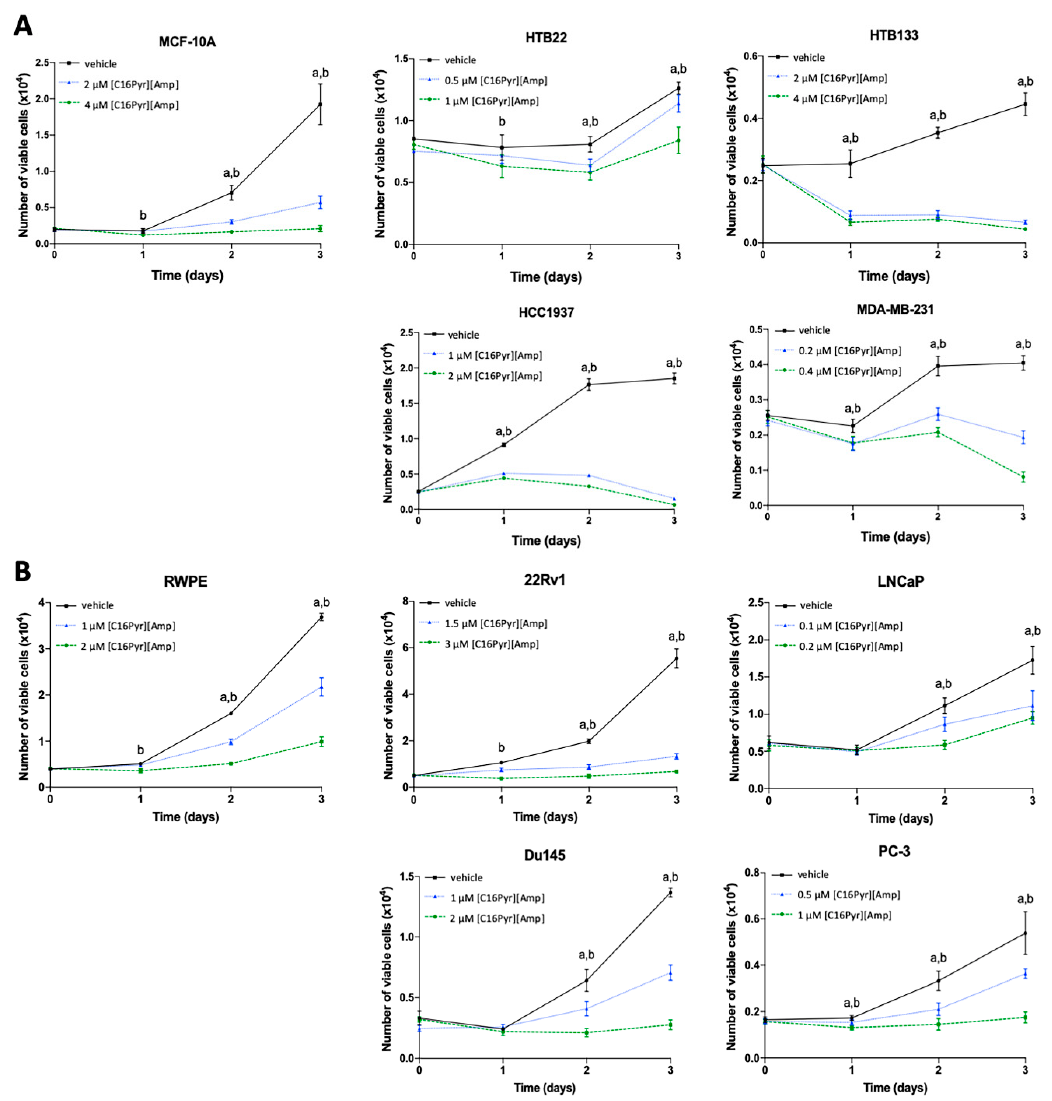
Figure 1. The impact of [C16Pyr][Amp] on cell viability at days 0, 1, 2, and 3 was measured by 3-(4,5-dimethylthiazol-2-yl)-2,5-diphenyltetrazolium-bromide (MTT) assay for the ( A ) breast (BrCa) and ( B ) prostate (PCa) cancer cell lines. Statistically significant differences ( p < 0.05) were observed between (a) the vehicle and the lowest concentration, as well as (b) the vehicle and the highest concentration. All data are presented as the mean of three independent experiments ± SD.